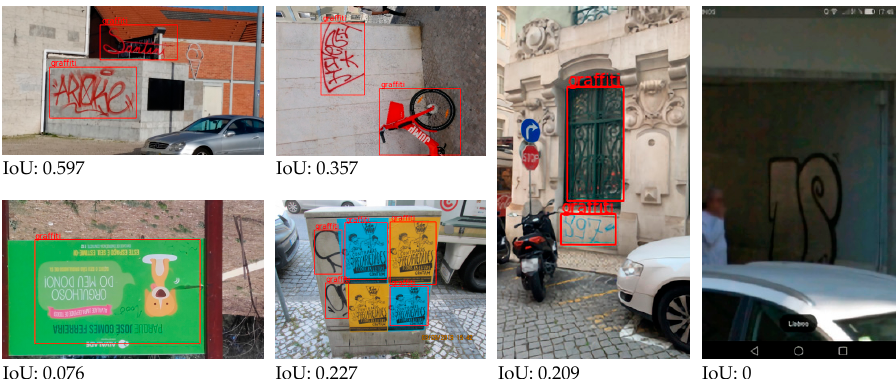
Figure 21. Graffiti detections with low IoU.